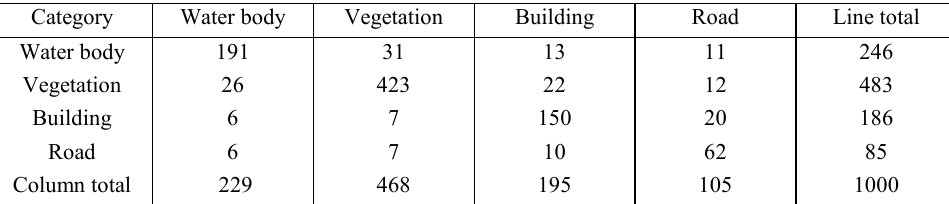
Table 1. ML classification obfuscation matrix